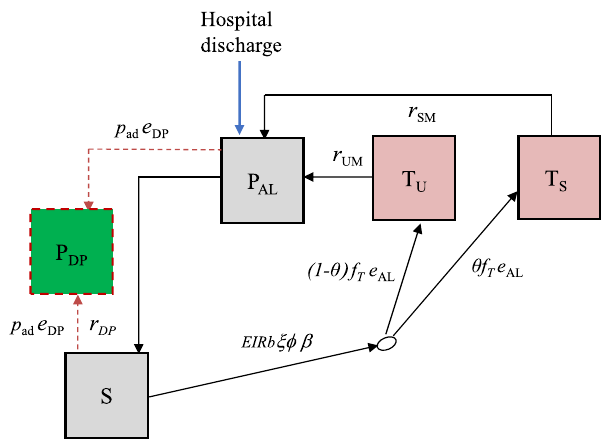
Fig. 4 | Post-discharge cohort model. Boxesrepresent health states,whilearrows and labels show health state transition rates and probabilities of an event. De fi ni- tions are given in the textand Table S1. Seesupplementaryinformation forfurther